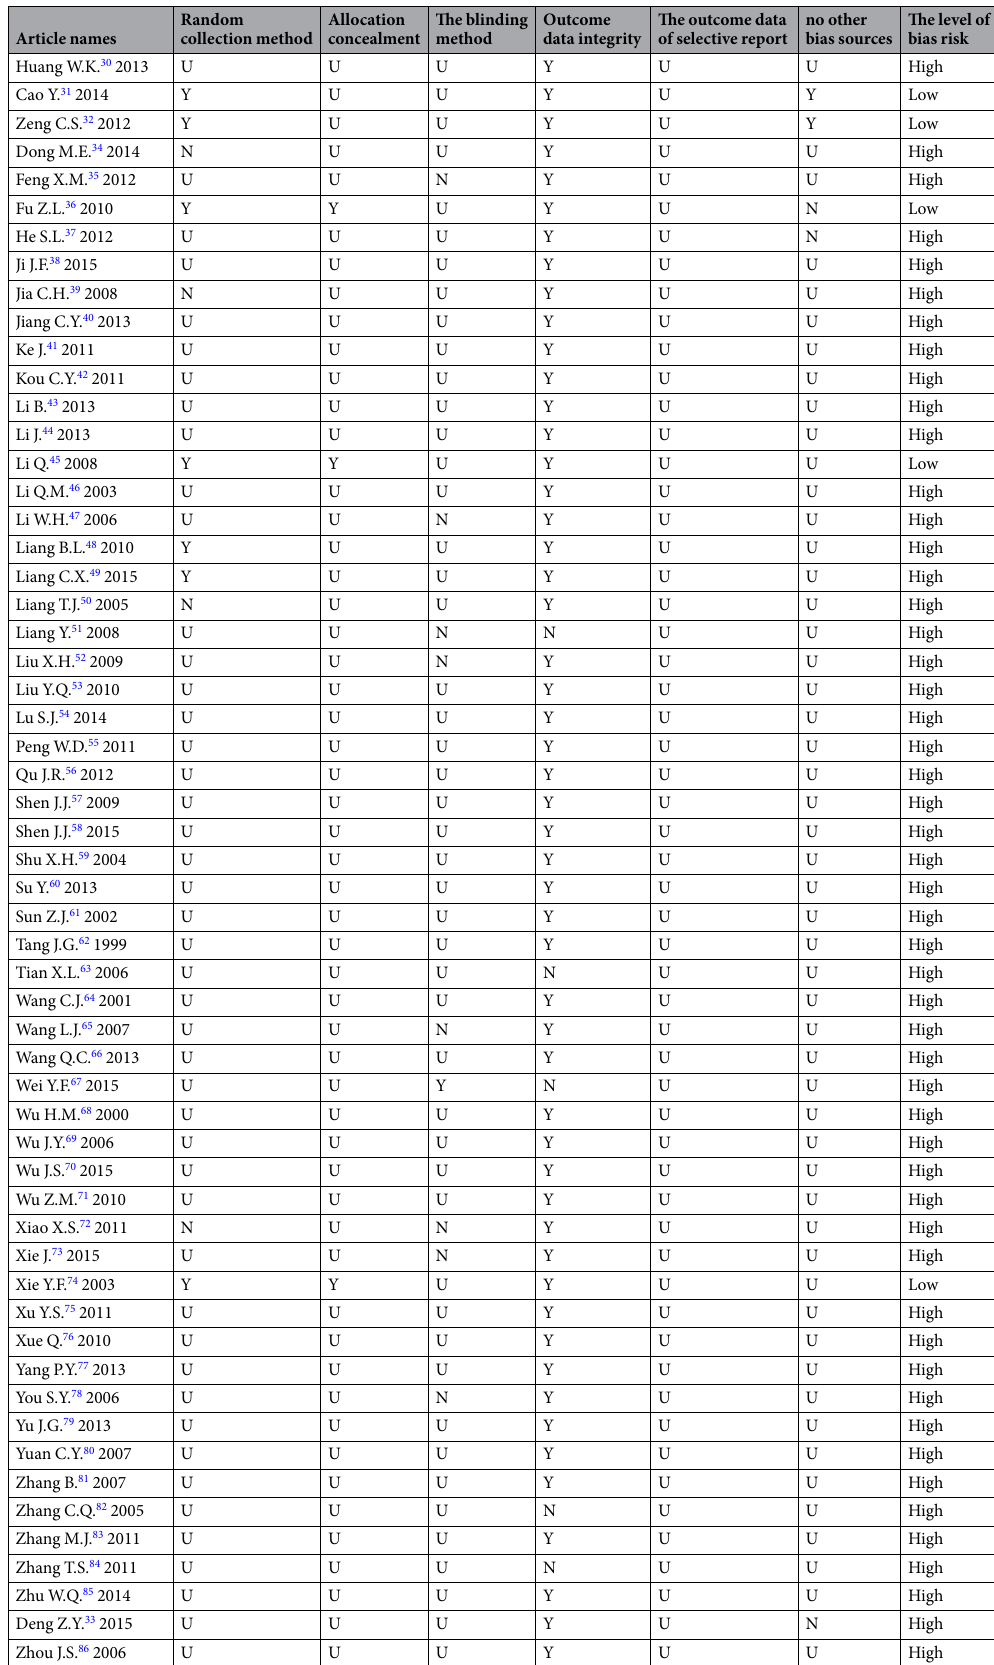
Table 2. The Risk Bias Evaluation of Articles Note: Y refers to “yeas”; N refers to “no”; U refers to